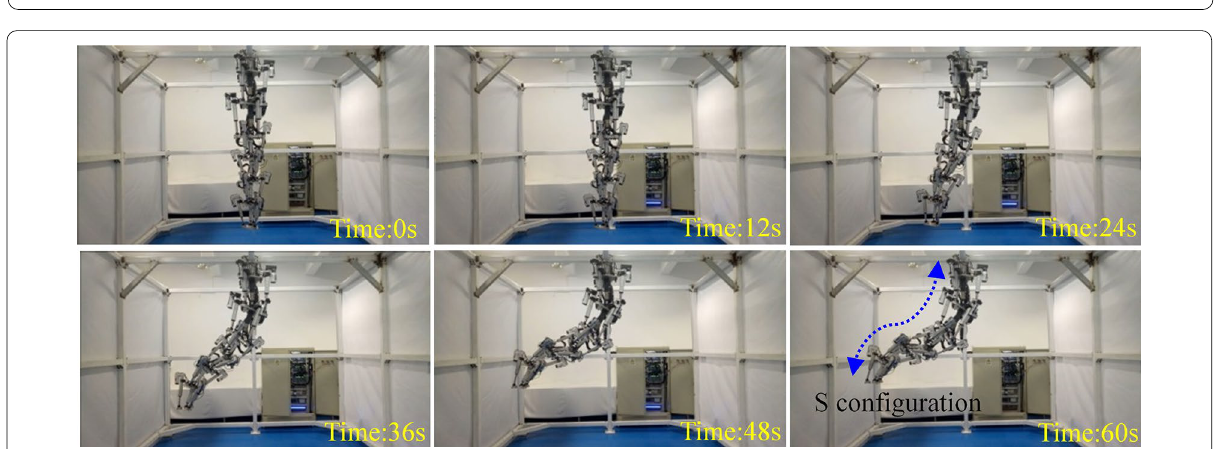
Figure 25 180° bending configuration of HRETR